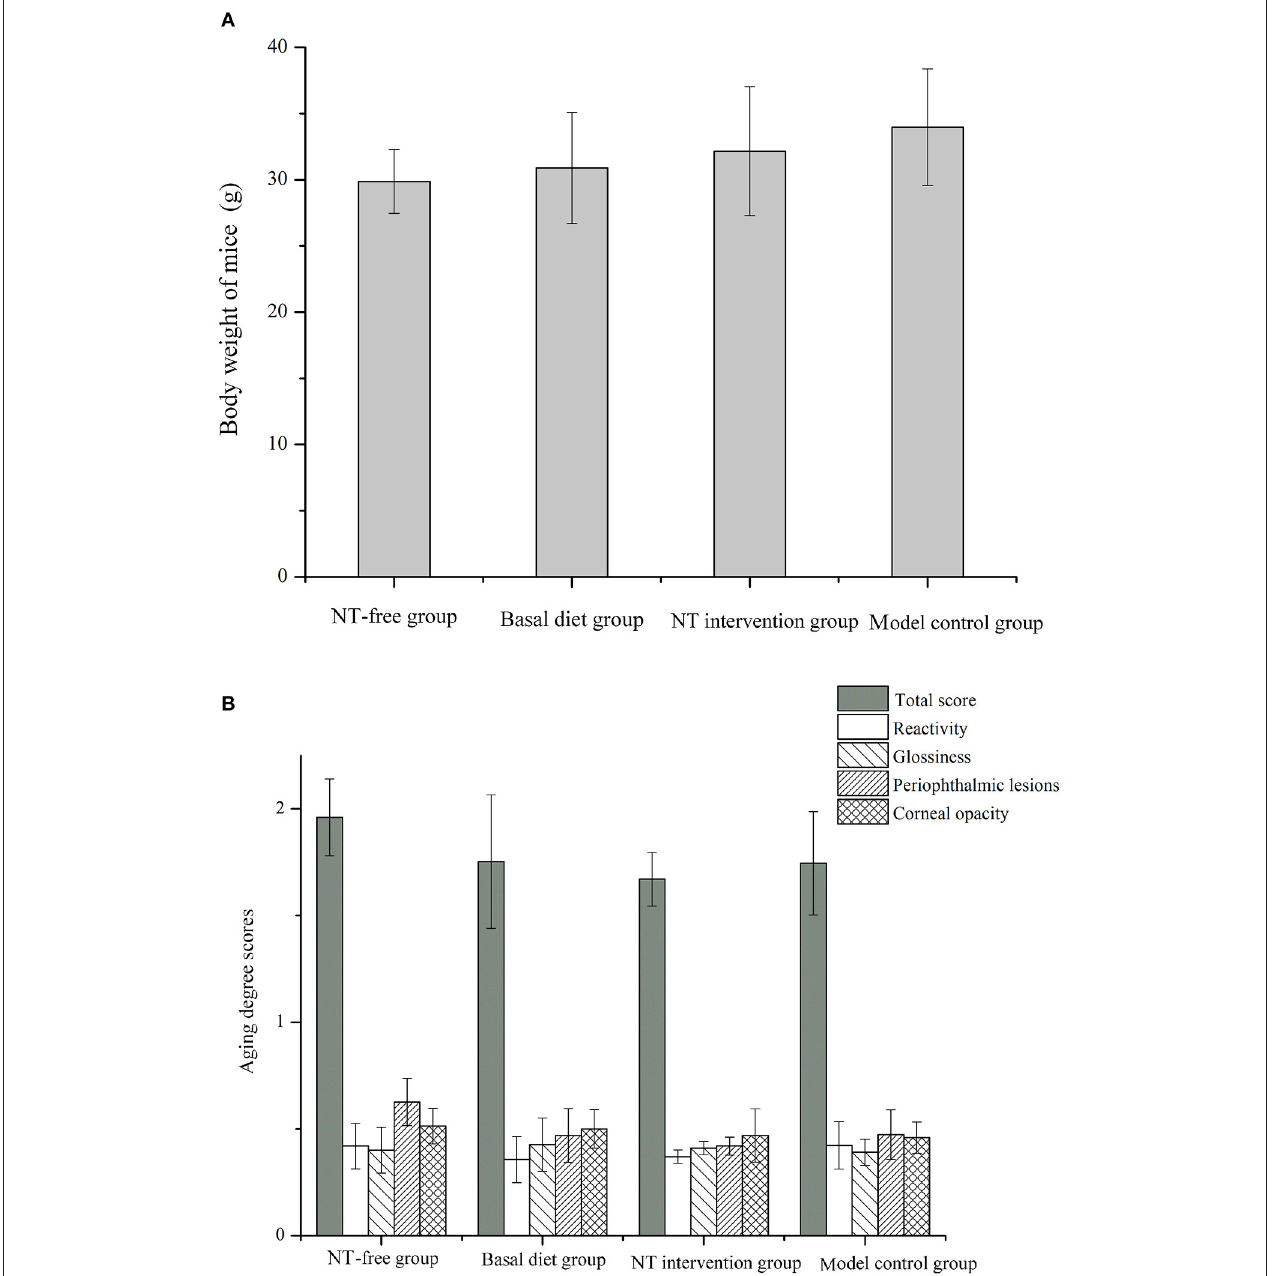
FIGURE 12 | The body weight (A) and aging degree scores (B) of mice in four